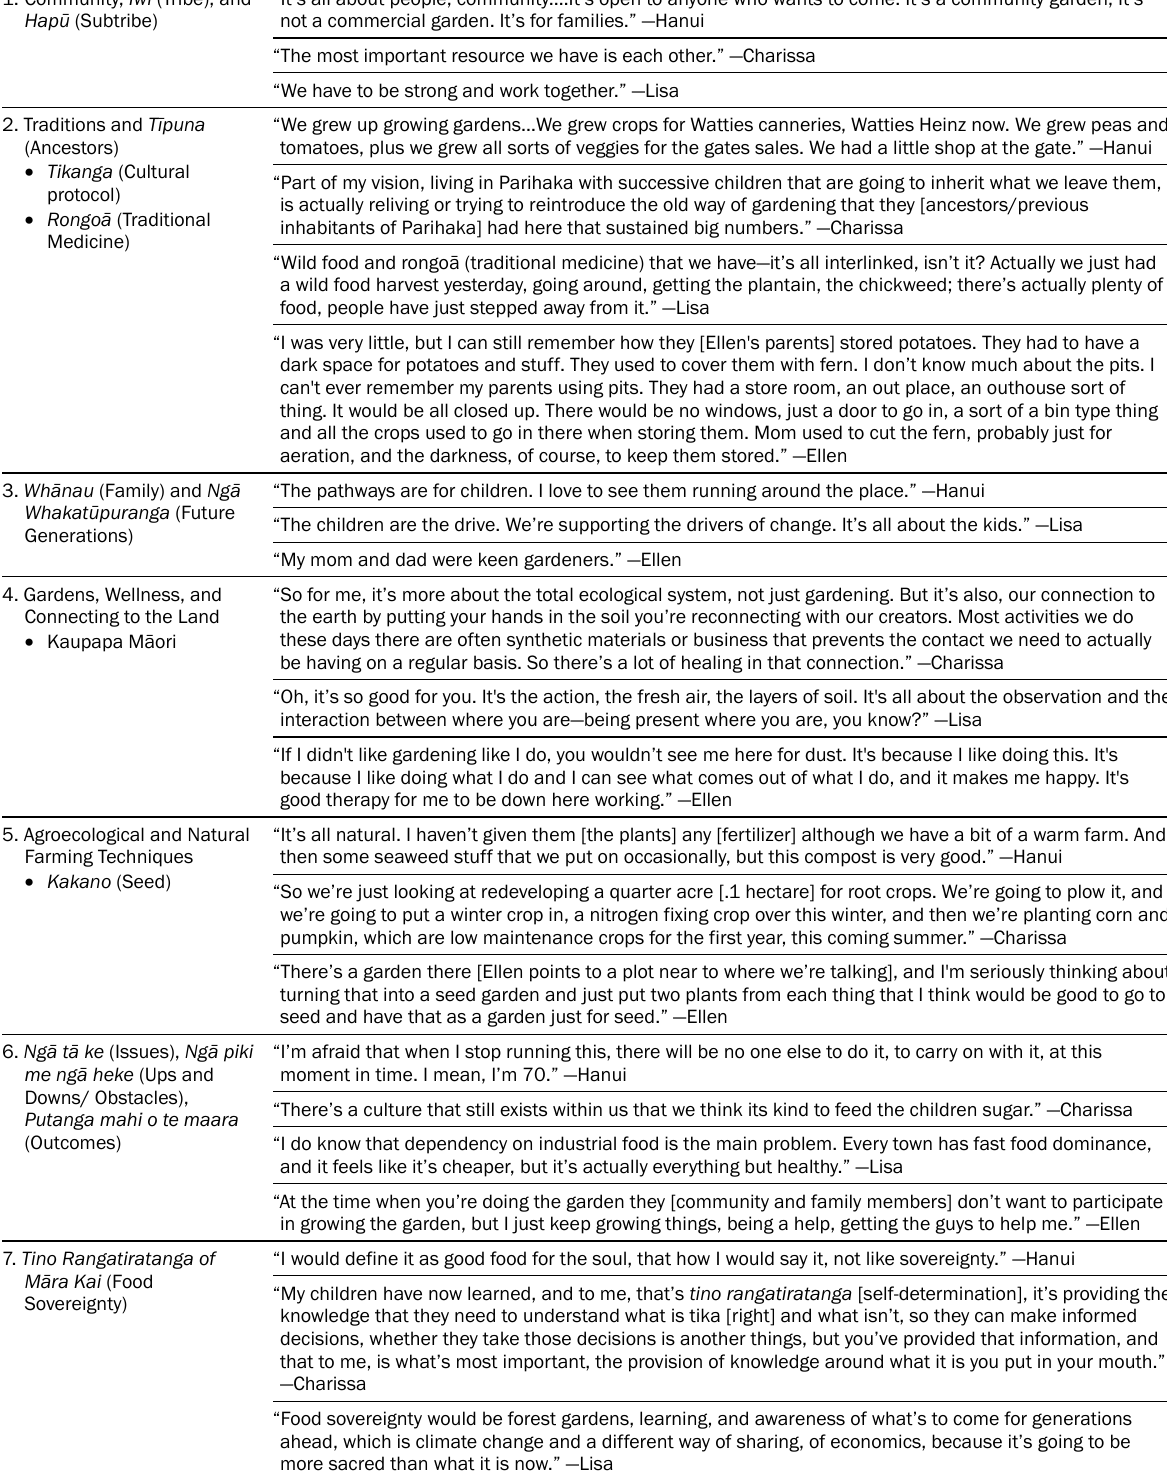
Table 3. Key Research Findings and